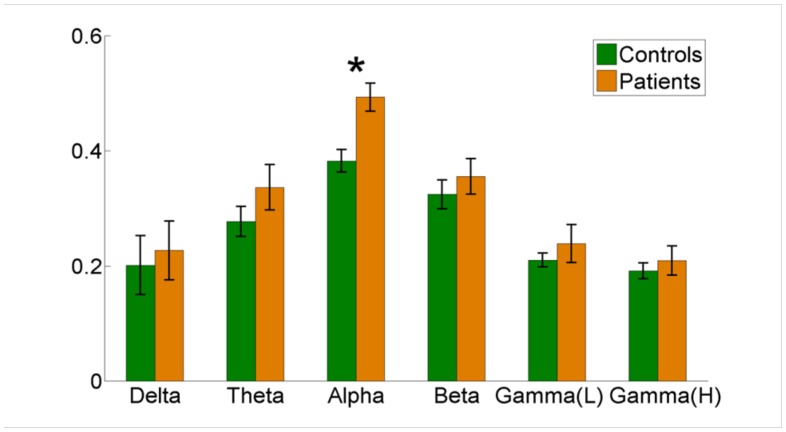
Aggregated nodal network connectivity.Assortativity of Partial Directed Coherence, showing differences between patients (Yellow) and controls (Green) with p = 0.0032 for Alpha range (Delta p = 0.74, theta p = 0.26, beta p = 0.46, gamma p = 0.47).